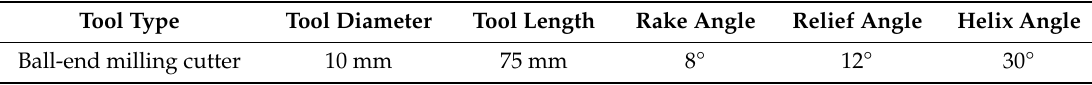
Table 1. Geometric parameters of the ball-end milling cutter.